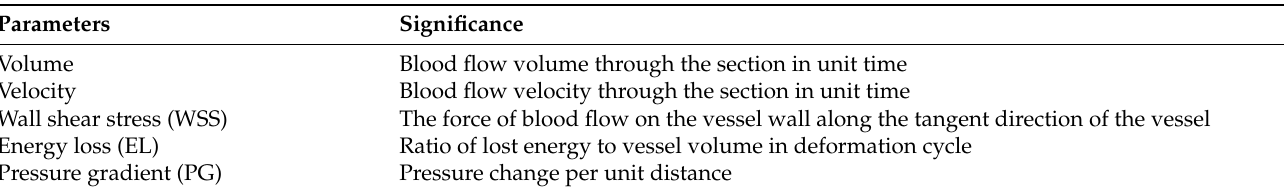
Table 2. Hemodynamic parameters and significance.